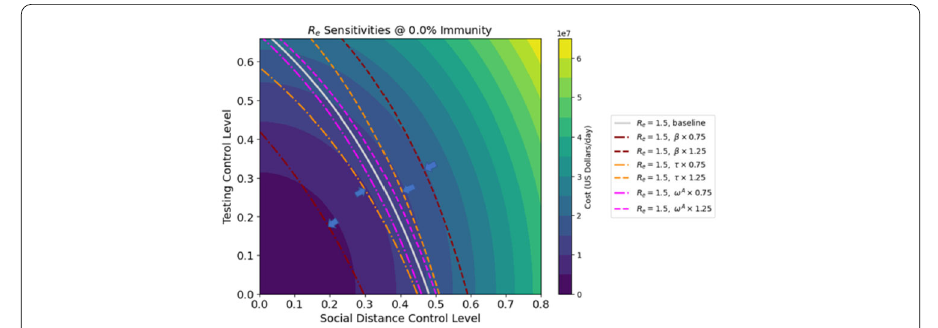
Figure 6 Sensitivity of R e at 0% immunity under different values of β , τ and ω A . Blue arrows indicate minimum-cost control solutions for different contours